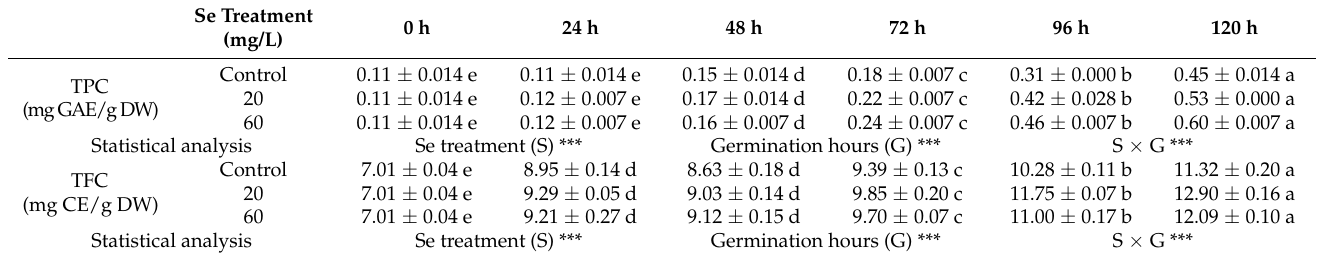
Table 4. Total phenolic and total flavonoid content with two different concentrations of Se